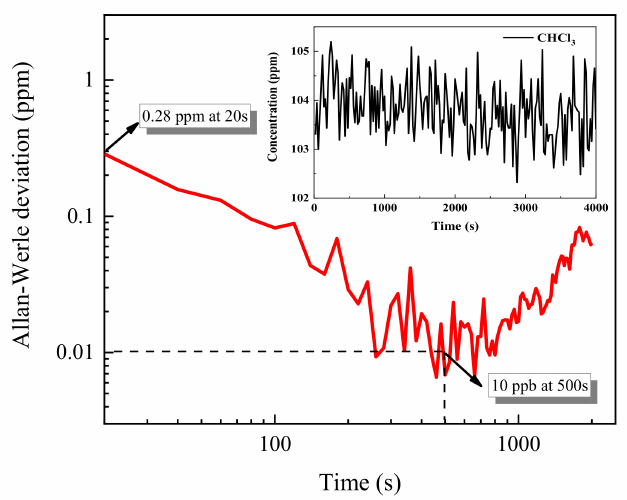
Figure 7. Plot of continuously measured data (at every 20 s) of chloroform gas concentration over 1 h and the corresponding Allan-Werle deviation analysis as the measurement time length (for averaging over each period of 20 s)